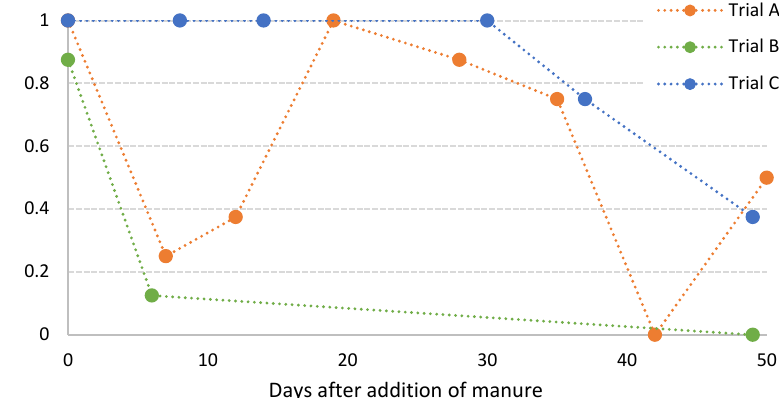
Figure 6. Proportion of samples positive for Listeria spp. in soil amended with dairy cow manure inoculated with L. innocua (n = 8).